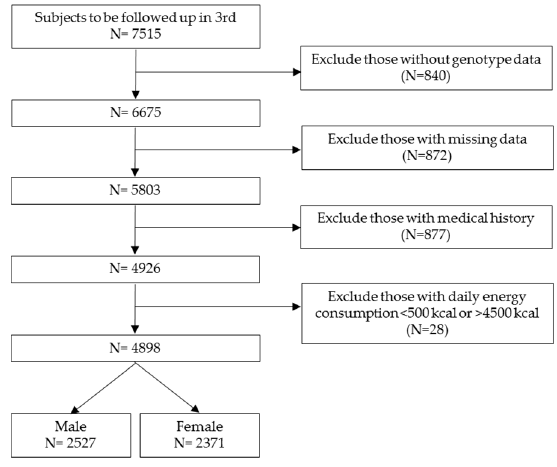
Figure 1. A flow chart of subject selection.